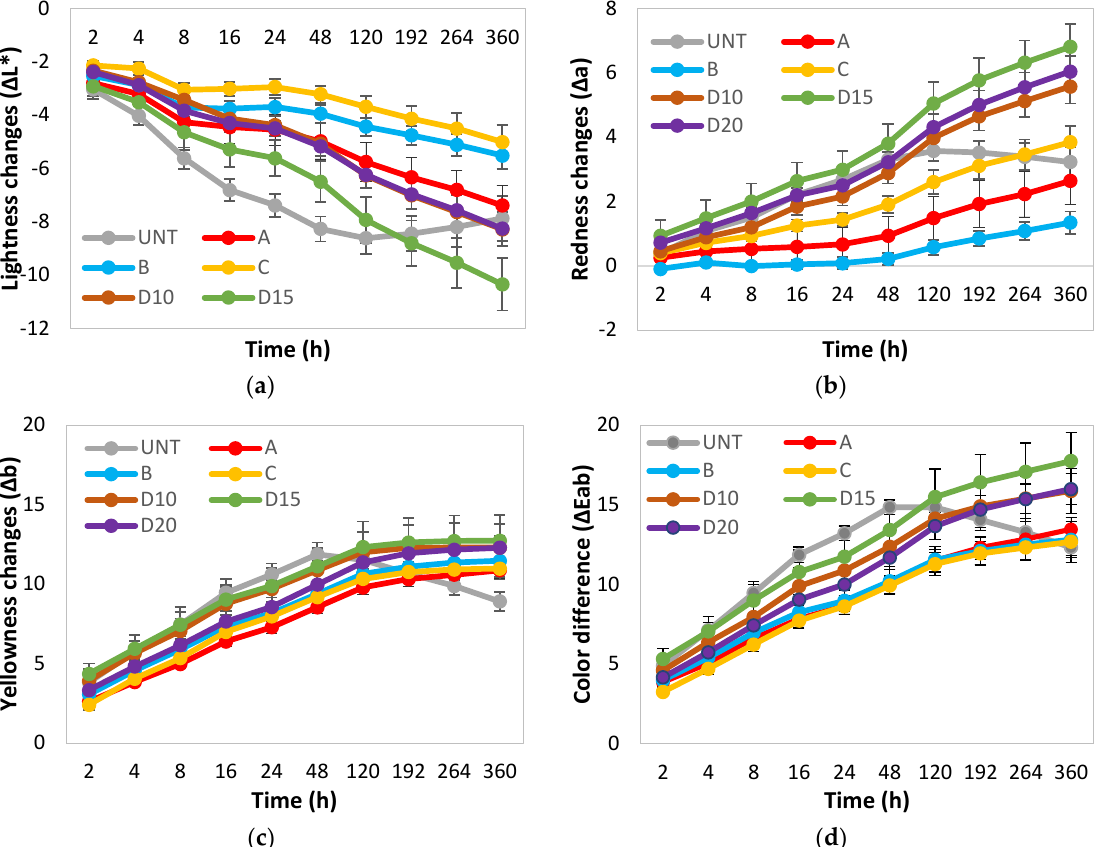
Figure 1. Changes in colour of untreated (UNT) and PF resin treated plywood after exposure to UV light during 360 h in QUV camera: ( a ) Changes in the CIE parameter ΔL* (lightness); ( b ) Changes in the CIE parameter Δa (red-green); ( c ) Changes in the CIE parameter Δb (yellow-blue); ( d ) colour difference parameter ΔEab.